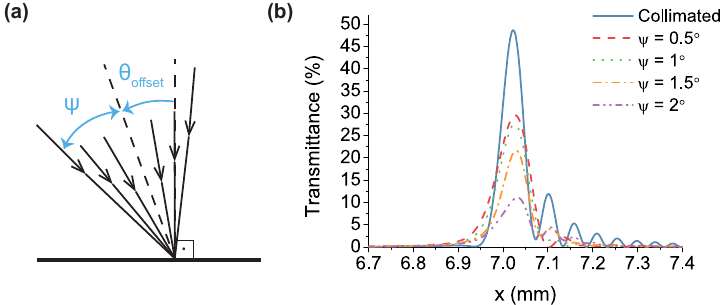
Figure 7. ( a ) the illustration of a light bundle impinging on the flat mirror of the LVOF; ( b ) transmission